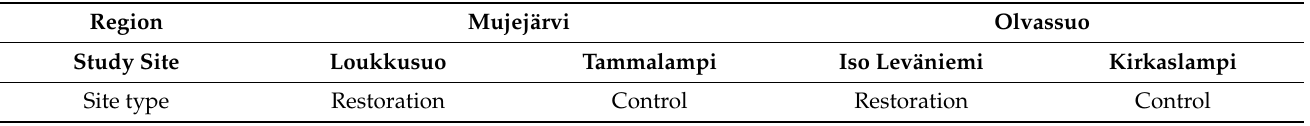
Table 1. Study site